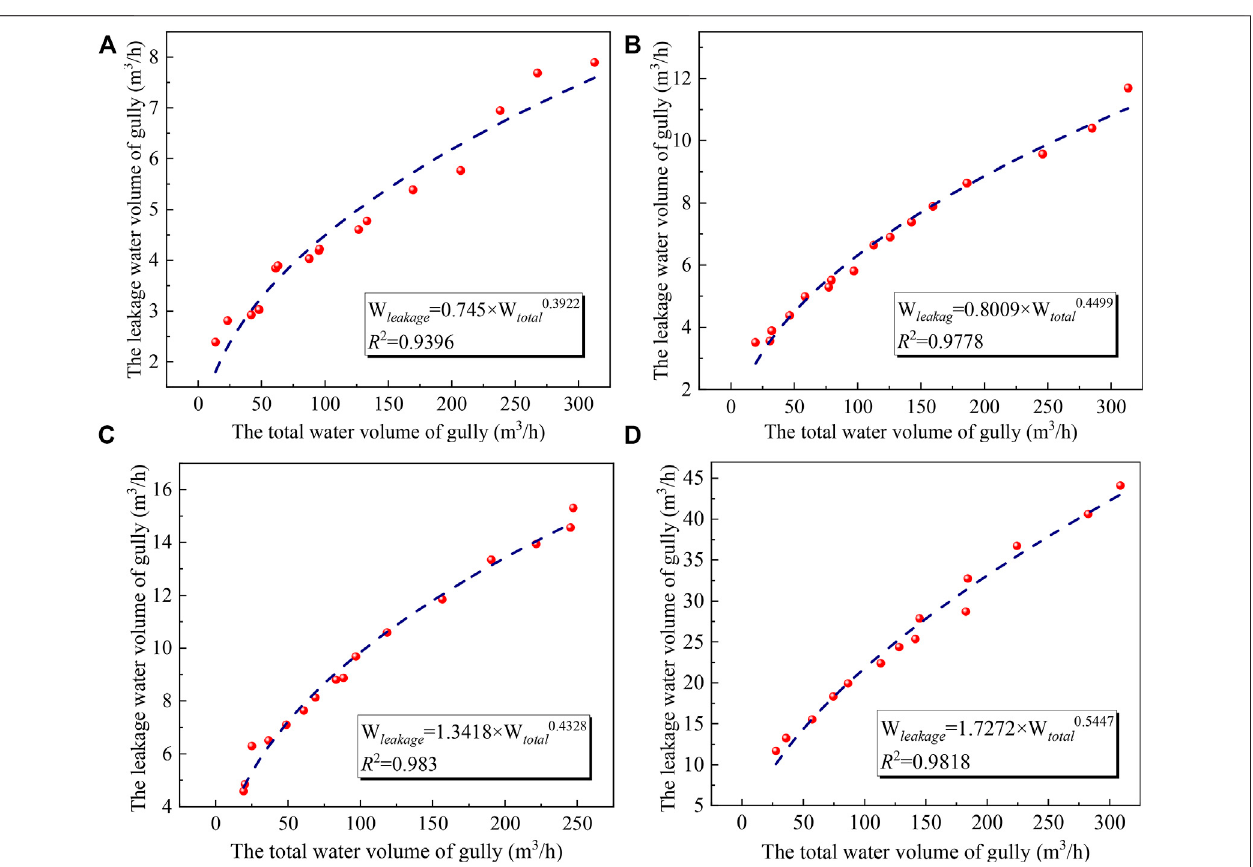
FIGURE 8 | Leakage for different experimental fi ssure widths: (A) 0.20 cm; (B) 0.40 cm; (C) 0.80 cm; (D) 2.00 cm.